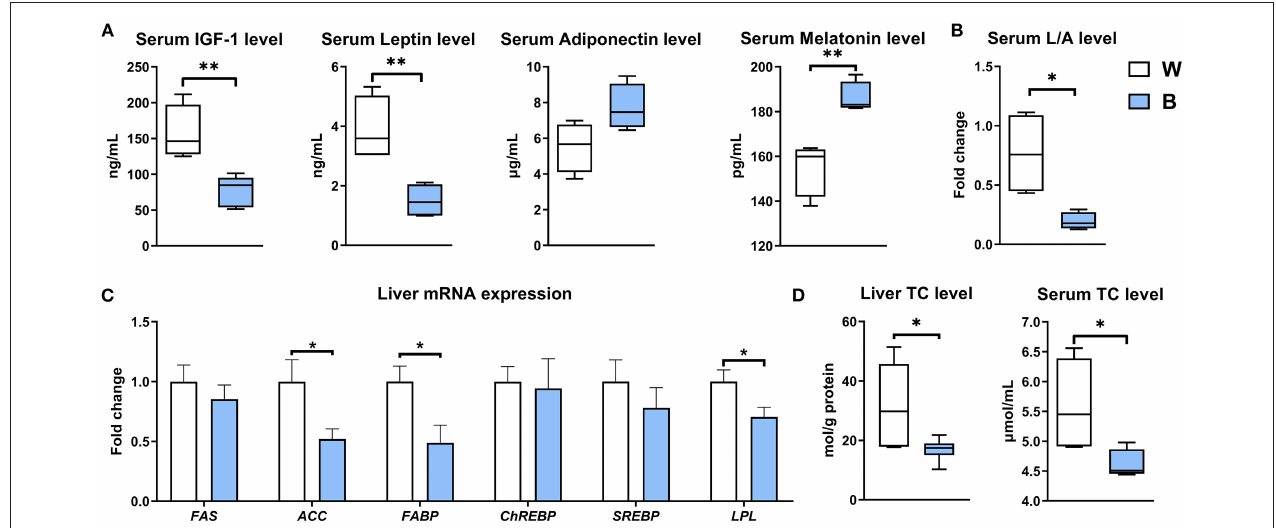
FIGURE 3 | Exposure to blue light reduces the accumulation of cholesterol in the liver and serum. (A) Effect of blue light on serum hormone levels of IGF-1, leptin, adiponectin, and melatonin in ducks ( n = 6, mean with SEM). (B) Effect of blue light on serum ratio of leptin to adiponectin in ducks ( n = 6, mean with SEM). (C) Relative mRNA expression of FAS , ACC , FABP , ChREBP , SREBP , and LPL in the liver of blue light-exposed ducks ( n = 6, mean with SEM). (D) Effect of blue light on the liver and serum total cholesterol levels in ducks ( n = 6, mean with SEM). Data in (A–D) were analyzed using the unpaired t -test, * P < 0.05, ** P <